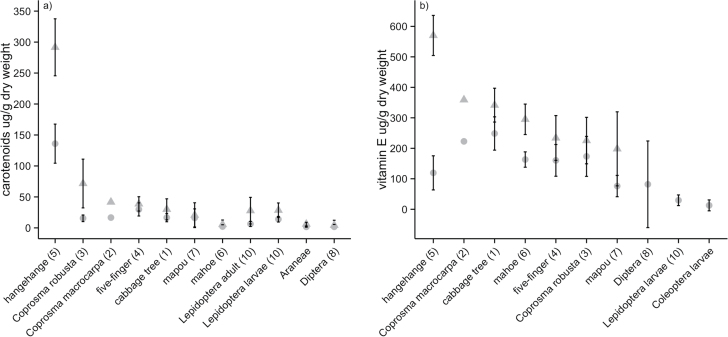
(a) Mean (± 95% confidence interval) total carotenoid (triangles) and lutein (circles) concentration (μg/g dry weight), and (b) mean (± 95% confidence interval) total vitamin E (triangles) and α-tocopherol (circles) concentration (μg/g dry weight) of different fruit species commonly fed on by hihi, and invertebrate orders potentially fed on by hihi (invertebrate data in (a) from Eeva et al. 2010; Finke 2013; invertebrate data in (b) from Finke 2002; Oonincx and Dierenfeld 2012; Finke 2013). Numbers in brackets correspond to fruit/invertebrate codes in legend of Figure 5.